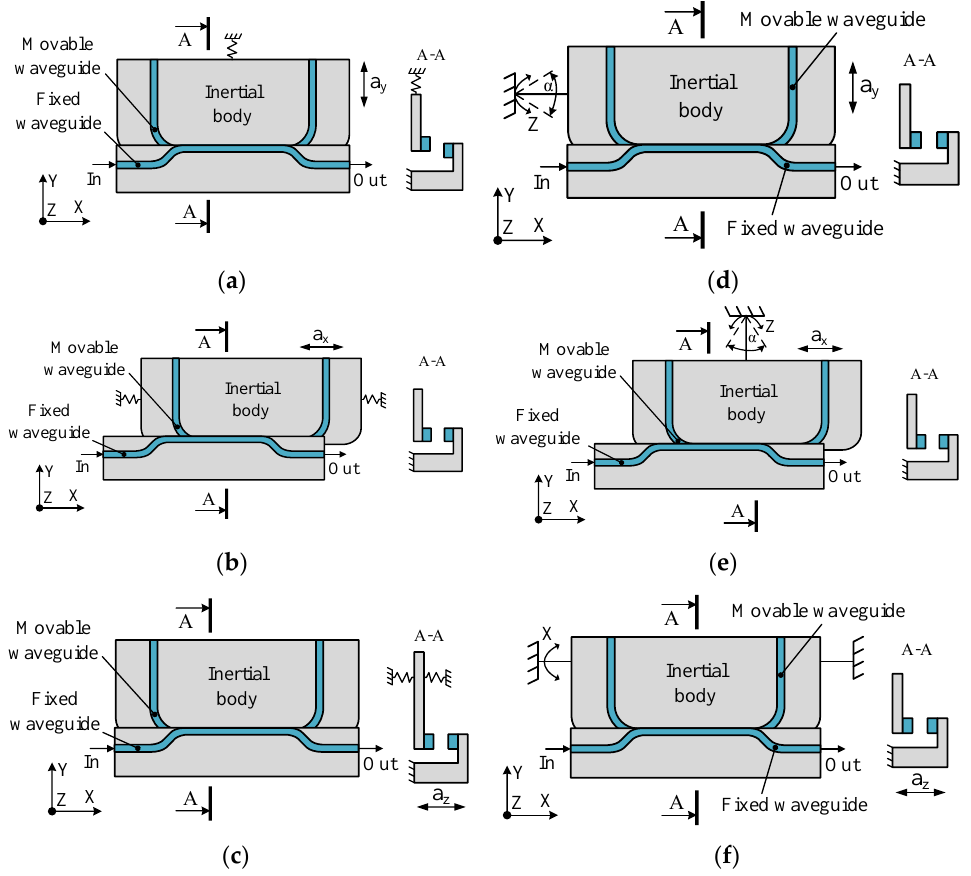
Figure 5. Functional schemes of the MOEM-accelerometer with different-plane waveguides. ( a ) Scheme 7, displacement along Y axis (overlap change); ( b ) Scheme 8, displacement along X axis (length change); ( c ) Scheme 9, displacement along Z axis (gap change); ( d ) Scheme 10, displacement around Z axis (overlap change); ( e ) Scheme 11, displacement around Z axis (length change); ( f ) Scheme 12, displacement around X or Y axis (gap change).